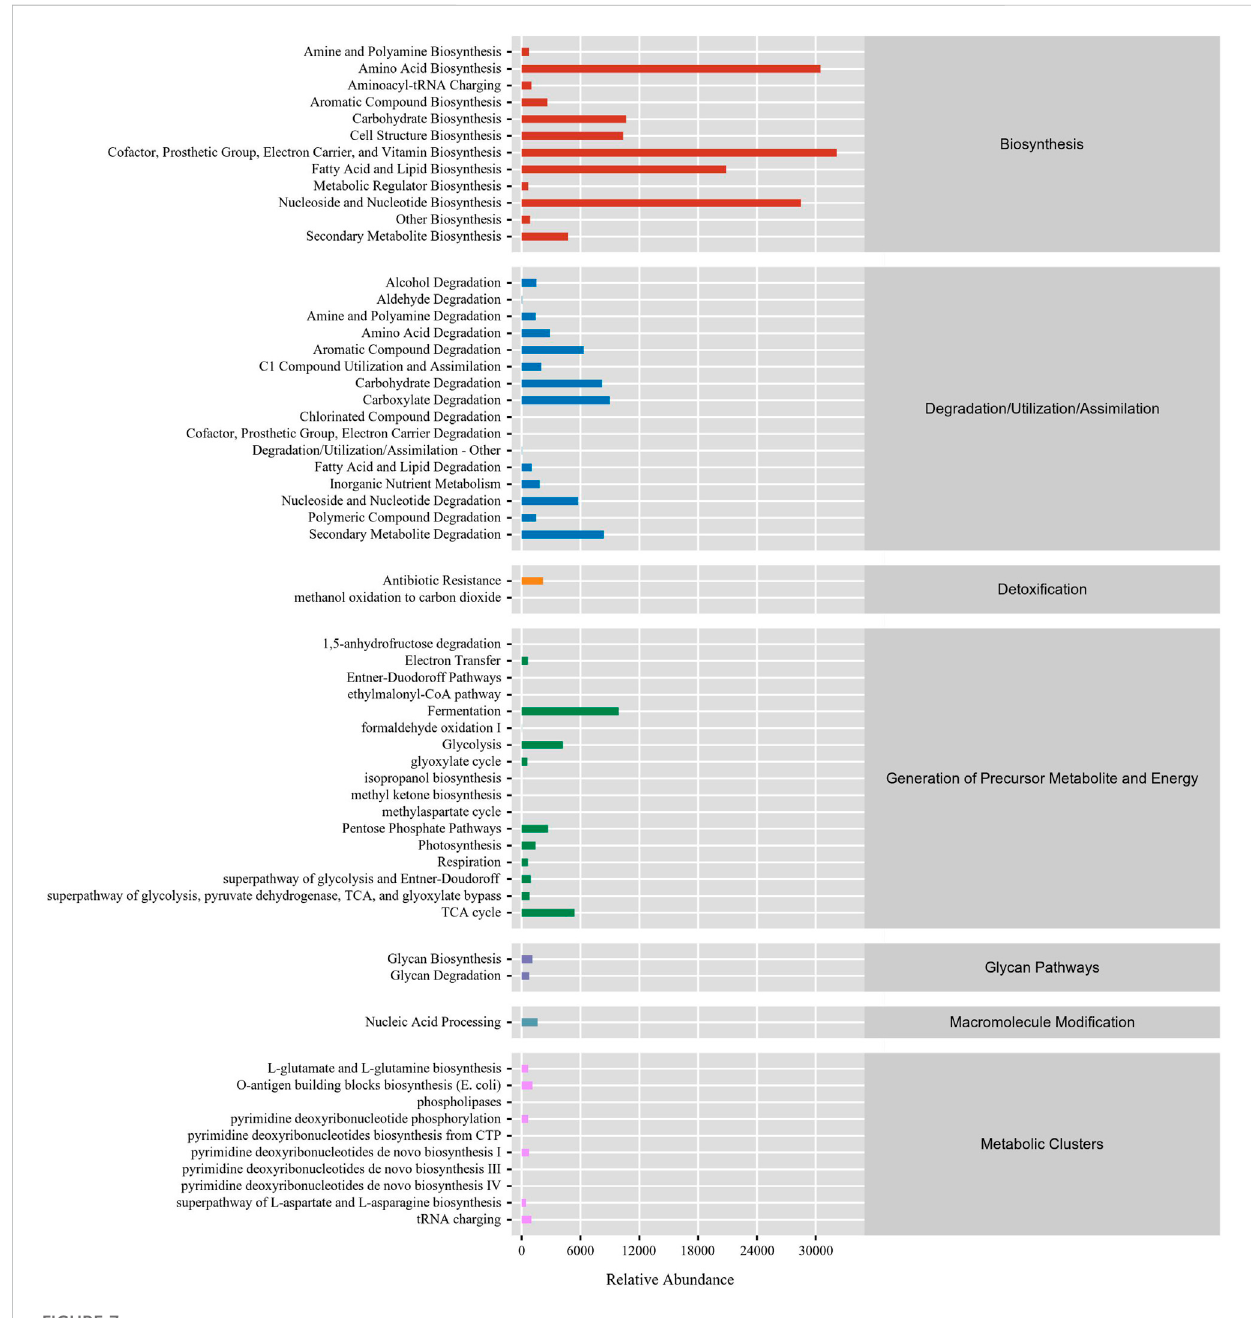
FIGURE 7 The function prediction of gut microbiota in C. bilineata tsingtauica